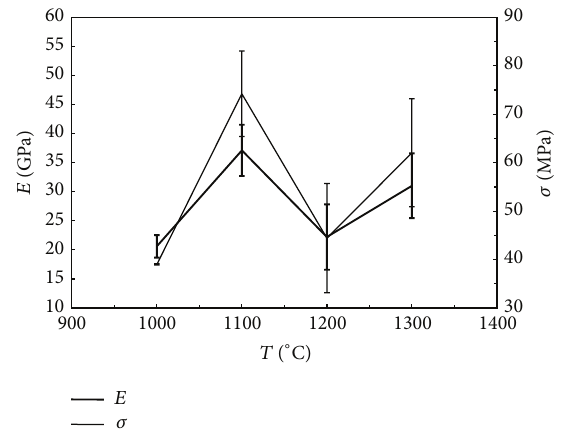
Figure 3: Influence of modulus of elasticity ( 𝐸 ) and compression strength ( 𝜎 ) of the BCP ceramics on sintering